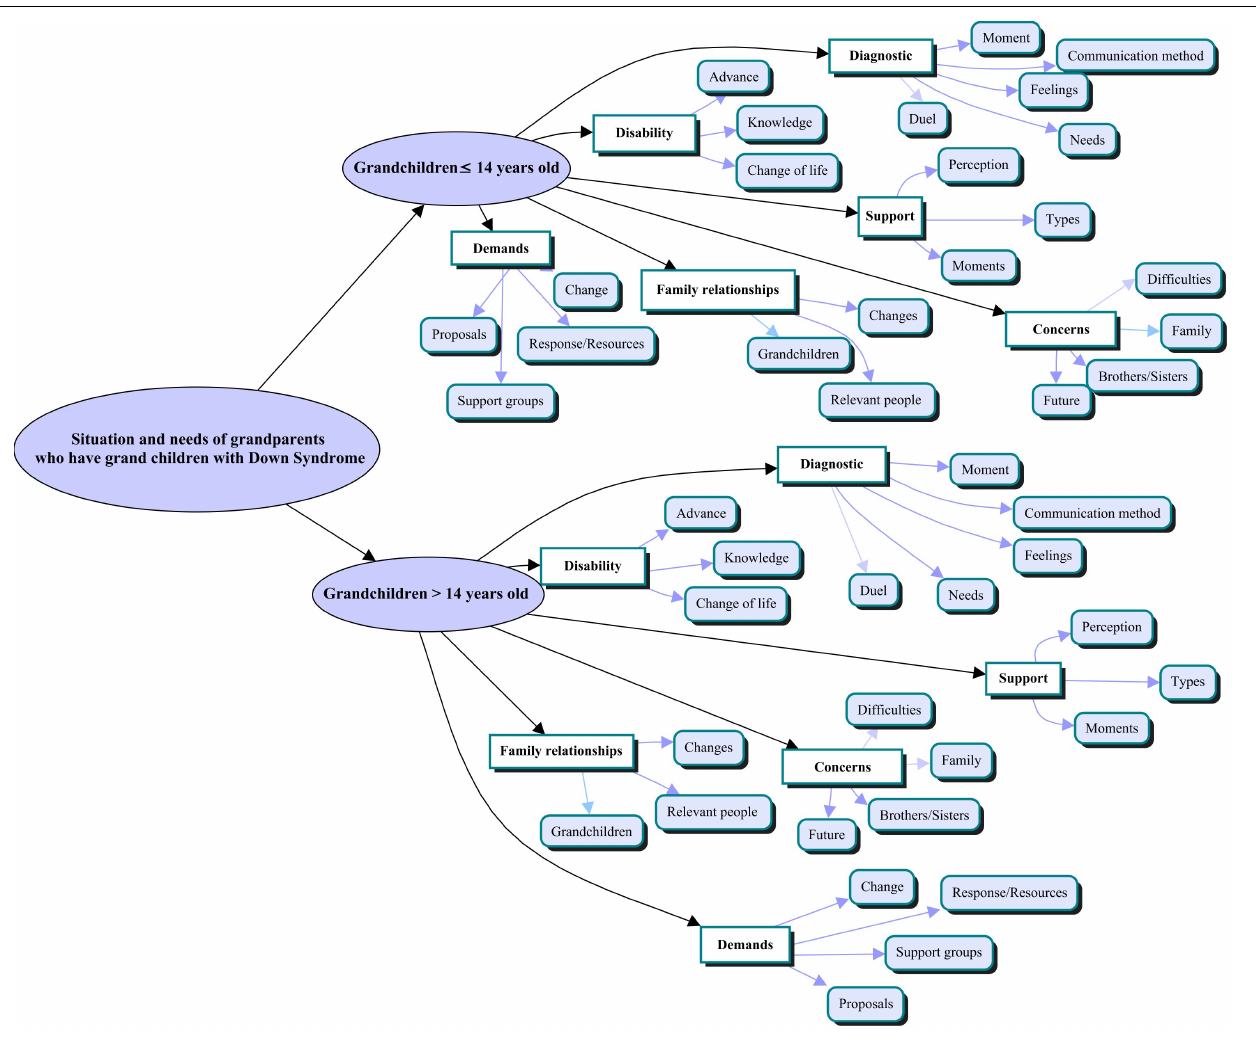
FIGURE 1 | Conceptual